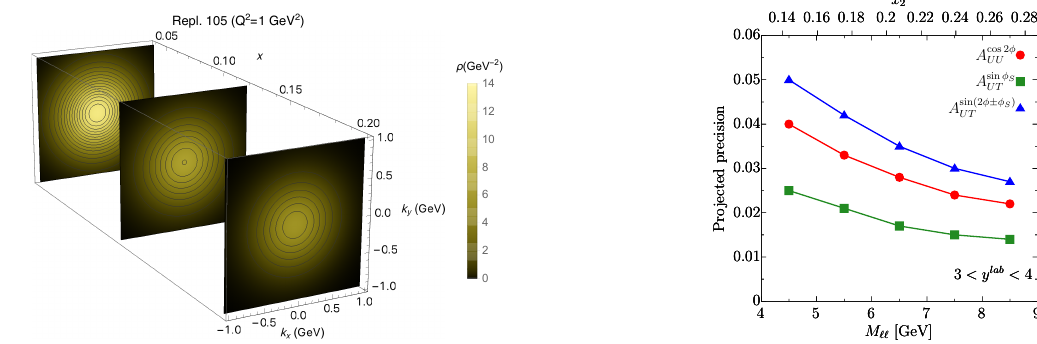
Figure 18: Three-dimensional representation of the u -quark densities in momentum space Figure 3: Left: up quark densities in momentum space [ 12 ] . Right: projected preci- (proton tomography) from a recent global analysis [122]. (Courtesy of A. Bacchetta). sion for some TSSAs with Drell-Yan data [ 7 ] with x being the longitudinal momen- 2 = 10 fb  1 Figure 39: Expected statistical uncertainty on asymmetries in DY production at AFTER@LHCb, computed all for L pp tum fraction of the target nucleon and M (cid:96)(cid:96) the dilepton invariant Two quark TMDs are involved in unpolarized processes: the standard unpolarized = 0 . 8. The rapidity has been integrated over the bins specified in the plots, as well as the mass in bins of dM = 1 GeV. [The and P e ↵ . distribution function f q and the Boer-Mulders function h ? ,q p 2 / p S + 2 B ,  ( A cos2  S statistical uncertainties are calculated using following expressions:  ( A sin  S ) = 1 / ) = 2 p 2 / p S + 2 B 1 1 UT UU P e ↵ . ⇥ p 2 / p S + 2 B , where S is the signal yield, B is the background yield and and  ( A sin(2  ±  S ) ) = 2 / is the effective UT P e ↵ . ⇥ P e ↵ . polarisation in a given measurement.]